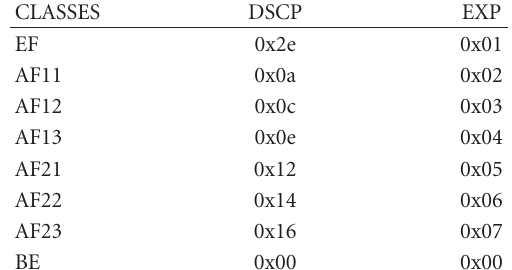
Table 3: Tra ffi c class mapping.